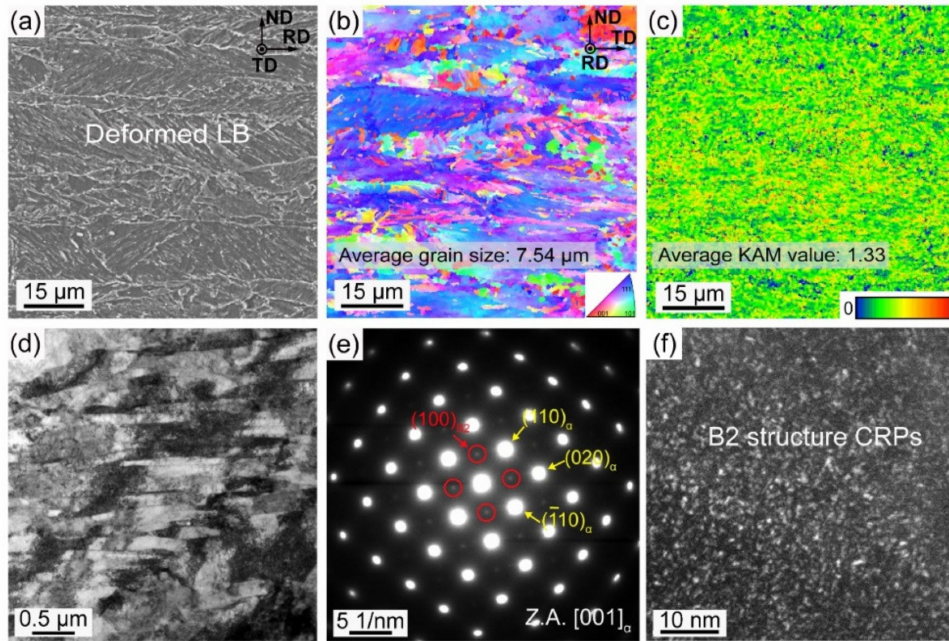
Figure 3. Microstructure features of the experimental steels. ( a ) SEM morphology, ( b ) orientation mapping from EBSD, ( c ) KAM map, ( d ) TEM bright field morphology, ( e ) SAED pattern along [001] α , and ( f ) dark field TEM